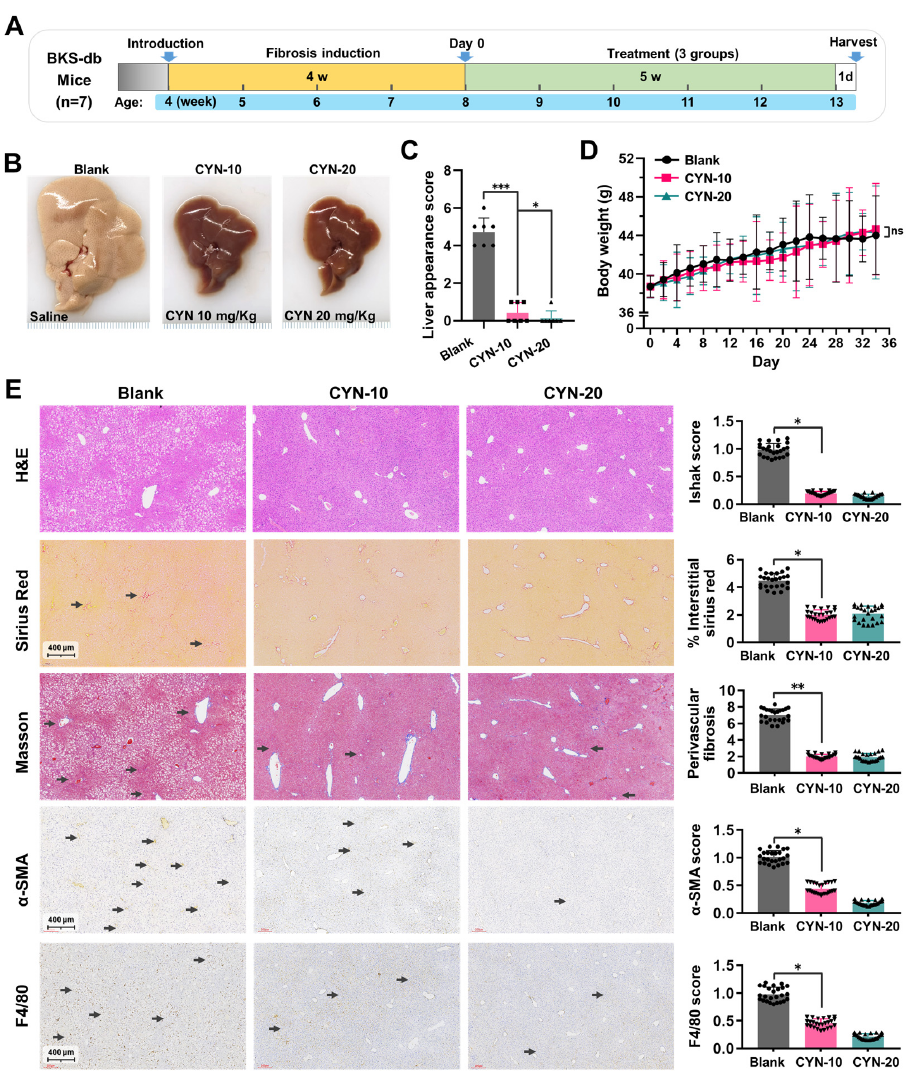
Figure 6. CYN attenuates the progression of NASH-background liver fibrosis. ( A ) Schematic of the animal experiment. ( B ) Liver appearance at the time of sample collection. ( C ) Liver appearance score. ( D ) The mouse weight trend over time. ( E ) Results of liver sections stained with H&E, Sirius Red, Masson, and IHC for α -SMA and EGF module-containing mucin-like receptor (F4/80). The statistics are based on quantitative data from 25 random fields of view for all animals in this group. The arrows indicate regions with pronounced staining. The results are marked as significant “*” when p < 0.05, “**” when p < 0.01, “***” when p < 0.001, and not significant (ns) if p ≥ 0.05. 3. Discussion In past studies, FGFR2 has shown the potential to be used as a target for the treatment of liver fibrosis [17,19,21–24]. Current evidence suggests that FGFR2 may be a promising target [25–27], but more research is needed to determine the efficacy of FGFR2 as a target for liver fibrosis treatment as well as to fully understand the mechanisms behind its involvement in TGF- β signaling. In this study, the correlation between FGFR2 expression and liver fibrosis development was demonstrated through data mining. The results from the cellular assays indicated heightened responsiveness to TGF- β signaling in stellate cells and hepatocytes with FGFR2 overexpression. The high expression of FGFR2 was also shown to facilitate the intercellular transmission of signals that activate stellate cells. In